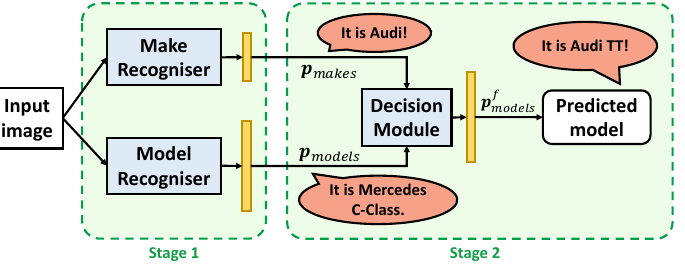
Figure 3. The scheme of the proposed Two-Branch–Two-Stage (2B–2S) framework for